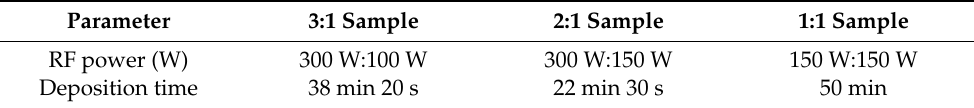
Table 2. RF magnetron sputtering system conditions for co-sputtered Ni/Cr alloy